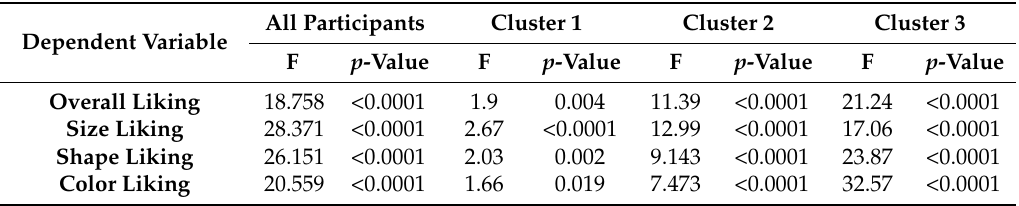
Table 4. Type III Sum of Squares for the two-way ANOVA tests for all the participants and for each of the three consumer clusters. Analysis of the impact of Sample on the model. Overall Liking, Size Liking, Shape Liking and Color Liking as dependent variables. Sample and Consumer as explanatory variables. A level of significance α = 0.05 was